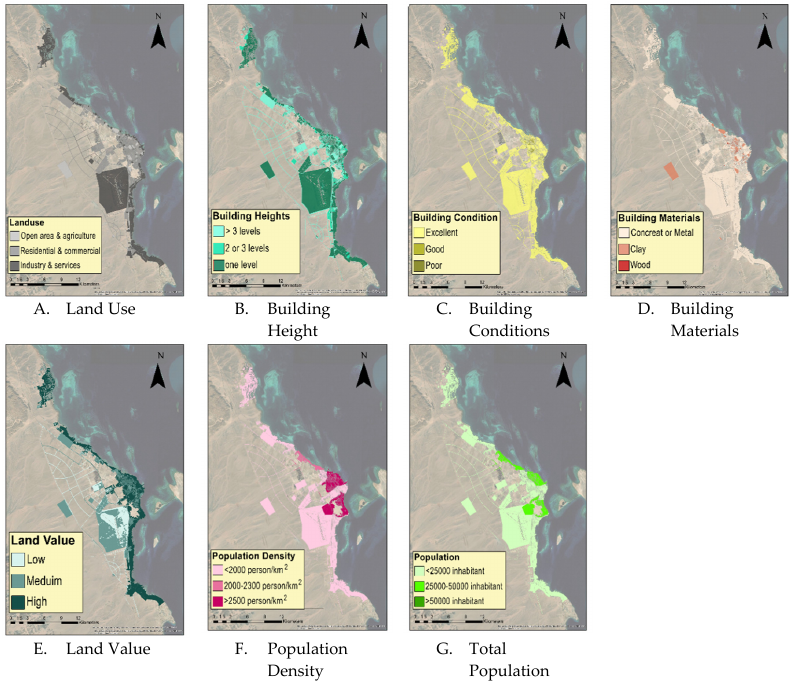
Figure 5. Selected vulnerability indicators from the city strategic plan (CSP) data sets (current). ( A ) Land Use. ( B ) Building Height. ( C ) Building Conditions. ( D ) Building Materials. ( E ) Land Value. ( F ) Population Density. ( G ) Total